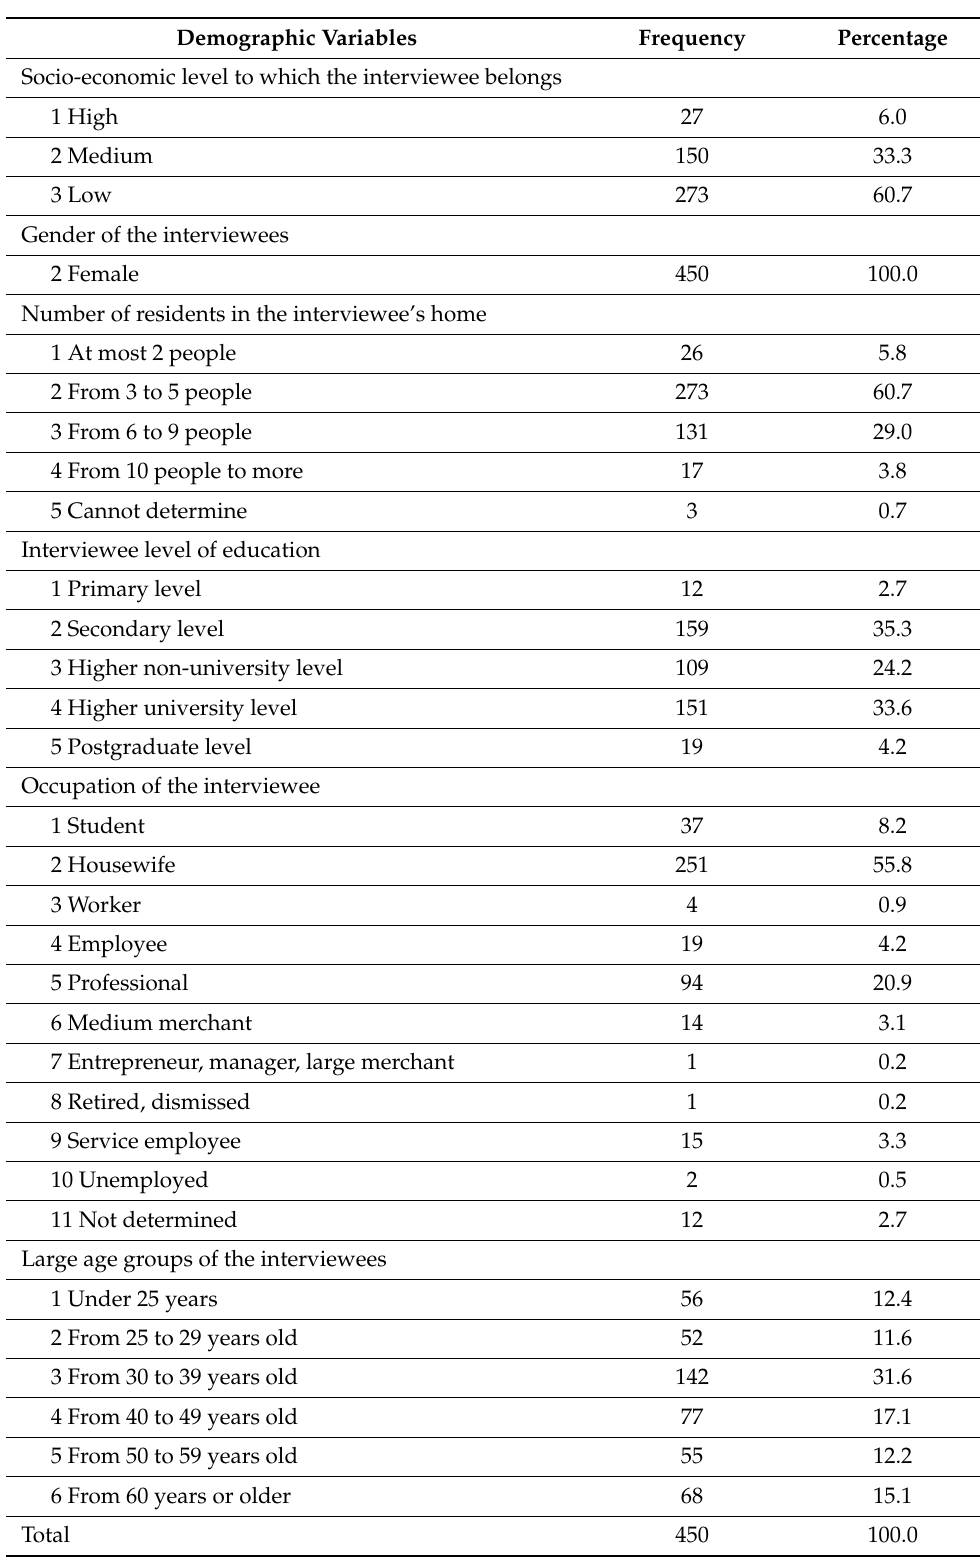
Table 1. Demographic profile of